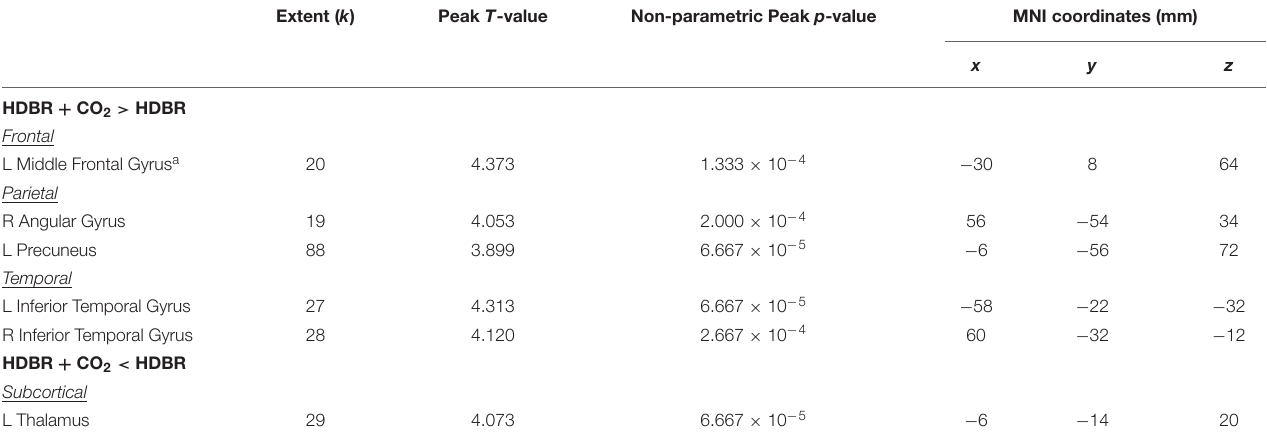
TABLE 6 | Regions with differences in slope of activation change with bed rest between HDBR + CO 2 and HDBR subjects. Extent ( k ) Peak T -value Non-parametric Peak p -value MNI coordinates (mm)